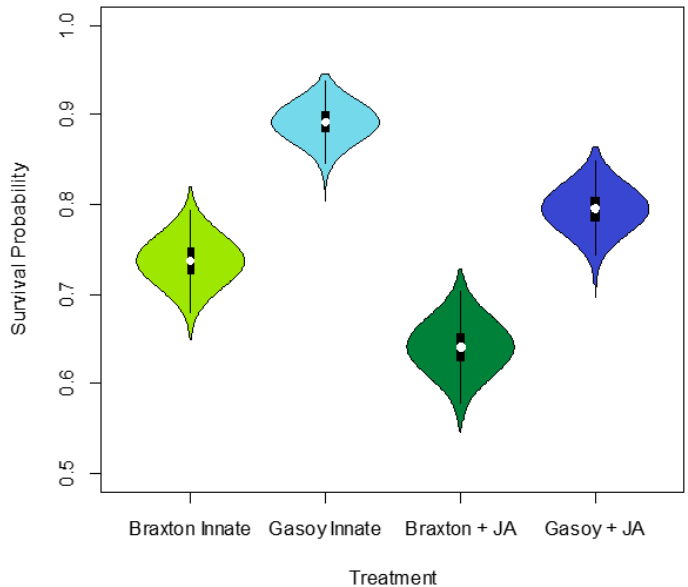
Figure 1. Probability of S. frugiperda 7-day survival ( y -axis) on different plant cultivars crossed with induction treatments ( x -axis). Cultivar affected insect survival with JA induction increasing larval mortality. Estimates in the figure are displayed as violin plots, represented as a traditional boxplot overlayed on a kernel density plot of the distribution of the Bayesian posterior estimates.